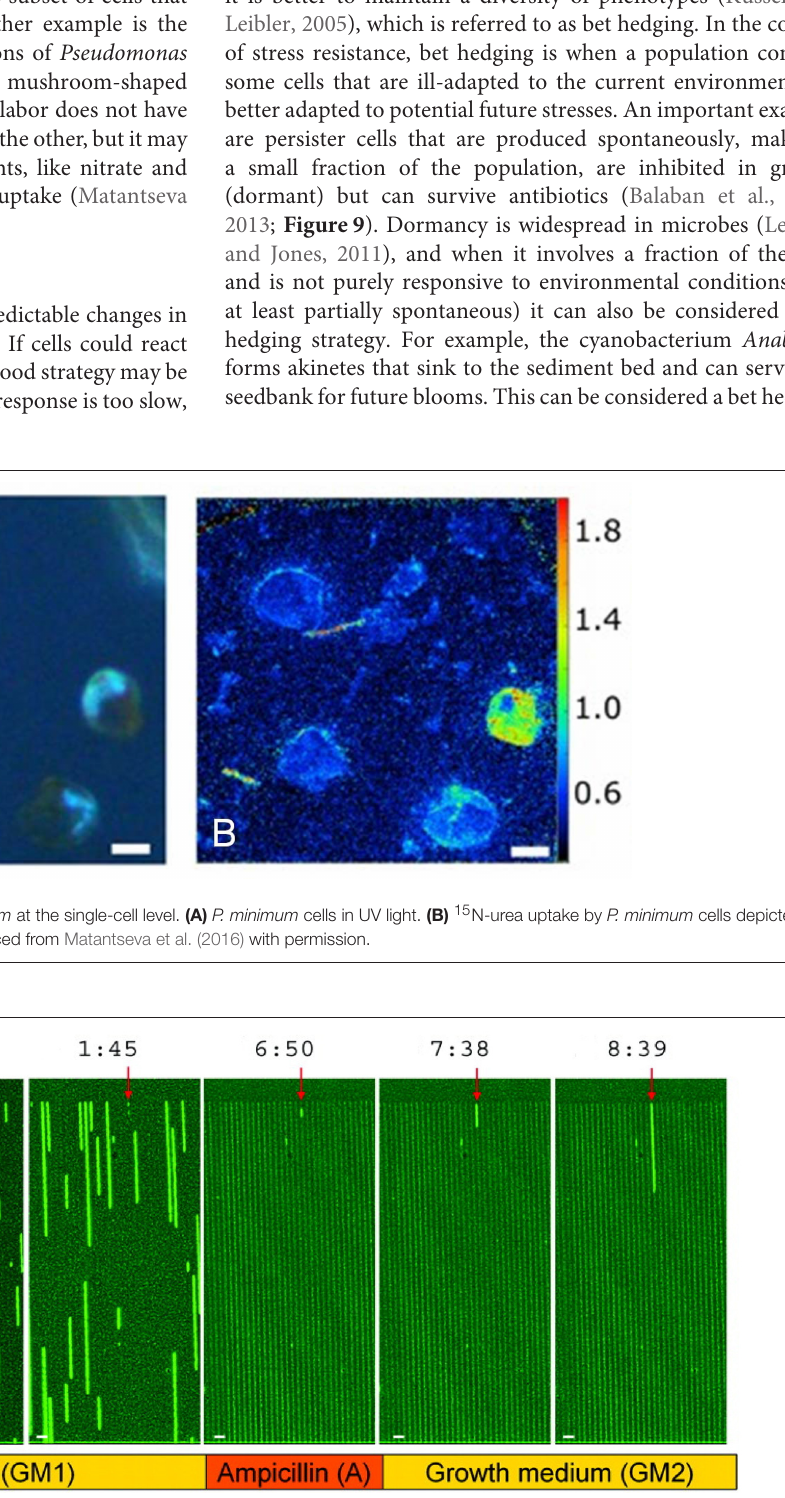
FIGURE 9 | Survival of persister cells under antibiotic treatment. Growth of a hipA7 mutant, which produces a larger fraction of persisters, in microfluidic channels. Times are in hours:min. Bacteria are exposed to three phases, including growth medium (GM1), ampicillin (A) and then washing and again growth medium (GM2). Persister cells are marked with a red arrow. Reproduced from Balaban et al. (2004) with permission.